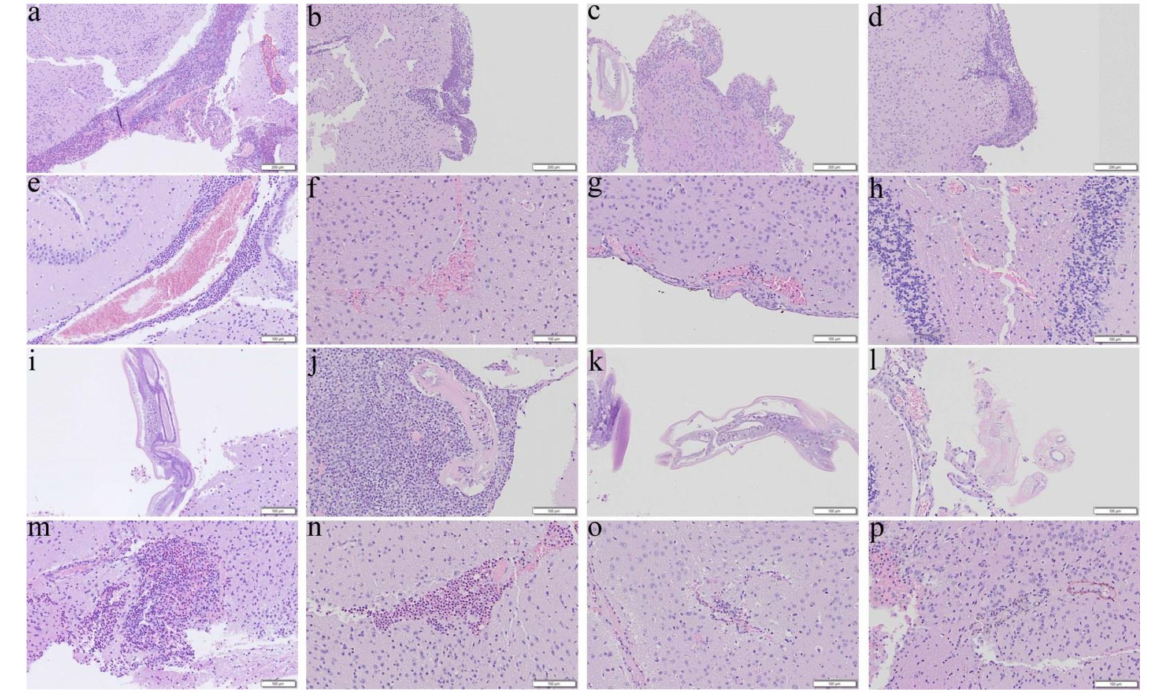
Figure 3. Representative photomicrographs showing meningitis, presence of worms, hemorrhage, and encephalitis in the cerebral parenchyma of the BALB/c mice infected with Angiostrongylus cantonensis treated from day 14 for 7 days. ( a , e , i , m ) Untreated mice. ( b , f , j , n ) Mice treated with albendazole alone. ( c , g , k , o ) Mice treated with dexamethasone alone. ( d , h , l , p ) Co-therapy of albendazole and dexamethasone.